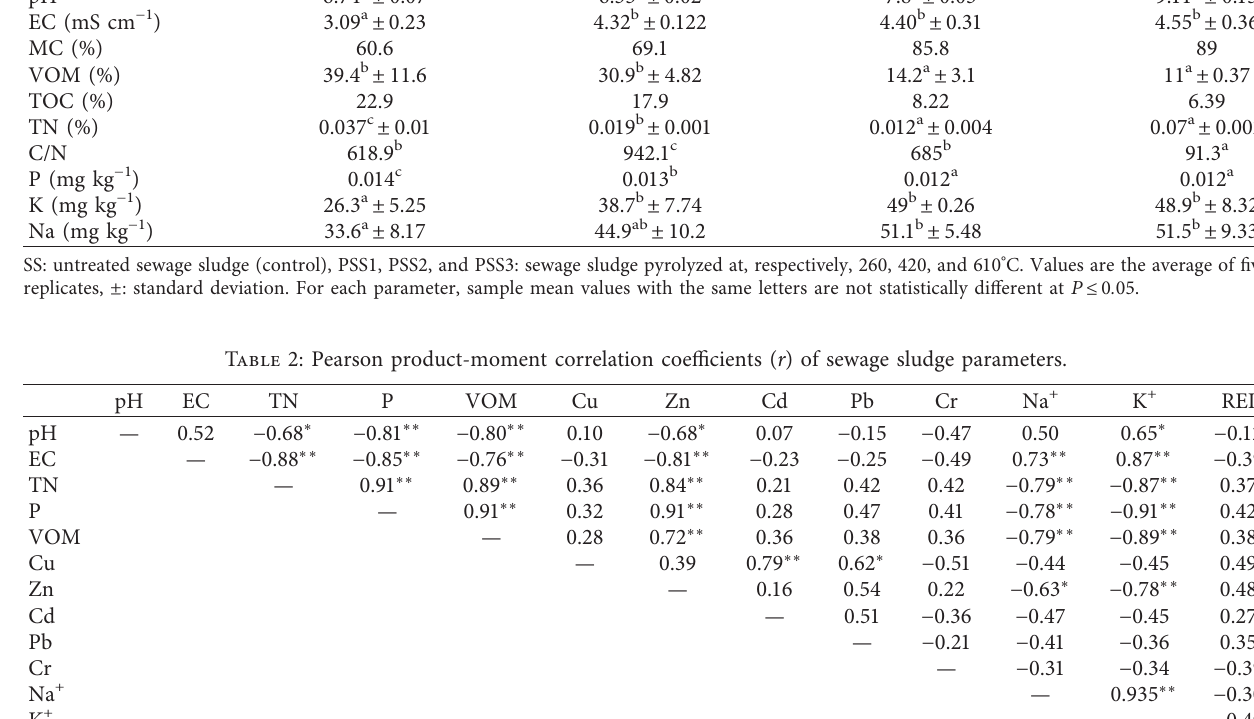
Table 1: Changes in the physicochemical properties of the sewage sludge and biochar samples obtained at different pyrolysis temperatures.